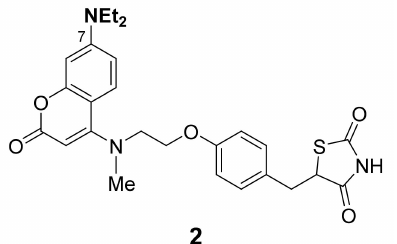
Figure 2. Structure of PPAR γ ligand incorporated 7-diethylamino (7-Et 2 N) coumarin.